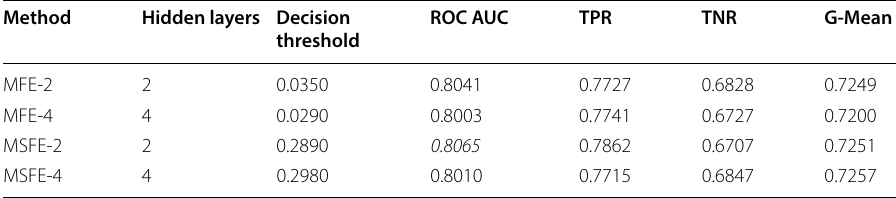
Italic font indicates the maximum ROC AUC